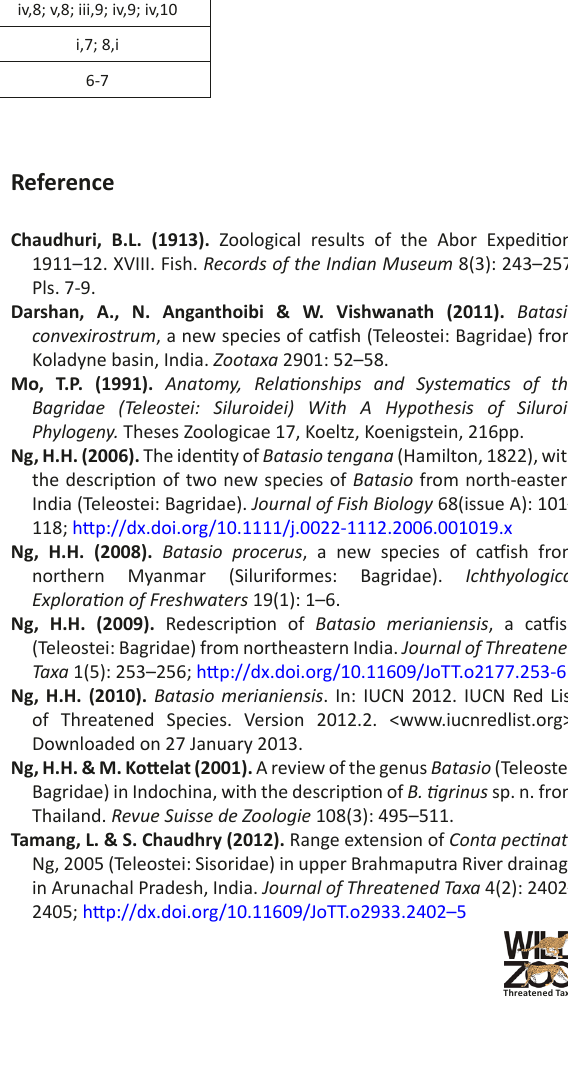
Table 2. Meristic data of B. merianiensis . Present specimens (n-6) Data from Ng (2009) (n=21) Dorsal fin rays 7 pectoral fin rays 7; 7,i; 8 7; 8